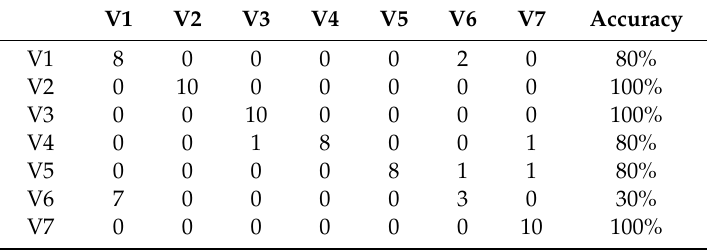
Table 6. Confusion matrix for sweet corn seed classification based on the SDA + K -NN model.